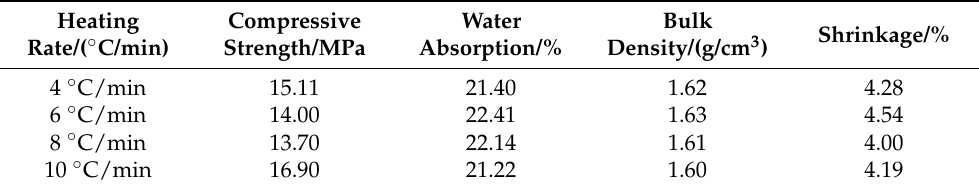
Table 6. Effect of heating rate on the properties of fired